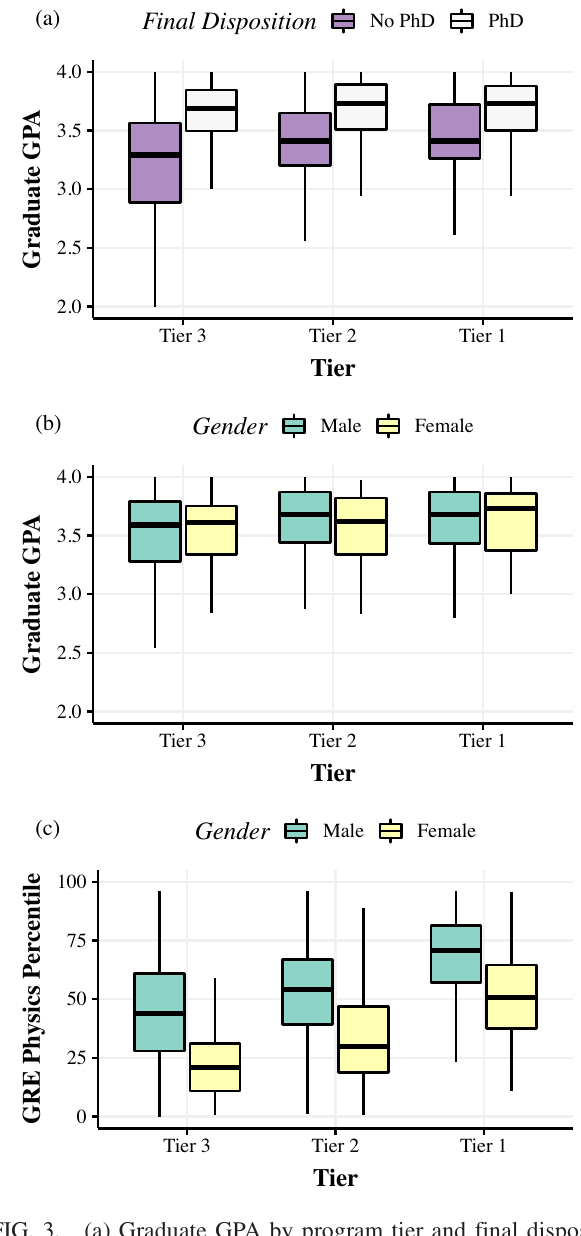
FIG. 3. (a) Graduate GPA by program tier and final disposi- tion. Students who do not complete a Ph.D. earn lower graduate grades than students who complete their programs ( r pb ¼ 0 . 43 , p < 0 . 001 ). Tier 3 students tend to earn slightly lower graduate course grades than tier 1 or 2 students. (b) Graduate GPA by program tier and gender. Male and female students earn similar graduate grades ( r pb ¼ − 0 . 01 , p ¼ 0 . 57 , equivalent to a non- significant independent t test), and this trend holds across program tier. (c) GRE Physics by program tier and gender. Across all program tiers there is a significant gap in scores between male and female GRE-P test takers ( r pb ¼ − 0 . 30 , p < 0 . 001 , equivalent to a statistically significant independent t test). Score distributions trend upward for higher tier